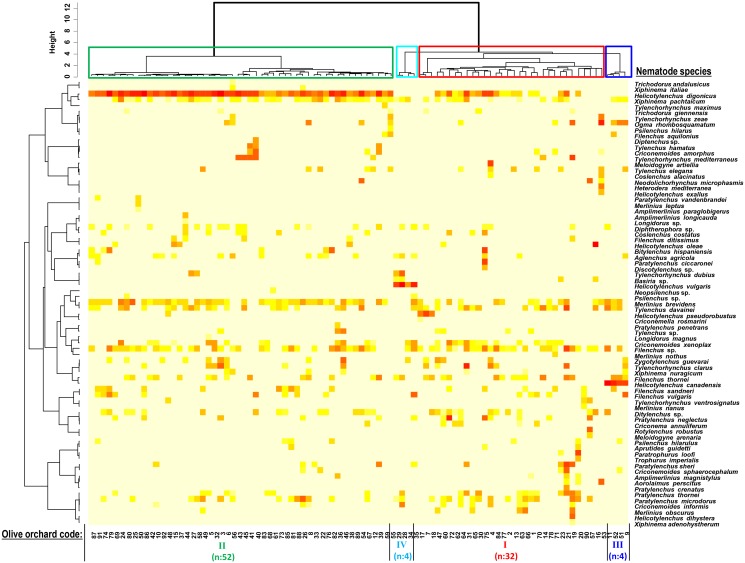
Unsupervised cluster analysis of PPN populations in olive orchards in southern Spain.The Ward linkage method was applied to the Bray–Curtis dissimilarity matrix calculated from frequency of occurrence of the 77 species of PPNs identified among the 92 olive orchard soils sampled. The optimum number of clusters and the degree of membership of an olive orchard to each of the four clusters was estimated on the basis of the maximum average silhouette width according to K-means partitioning (S1 Fig.). The intensity of color (from light yellow to deep red) shown for each nematode species correlates with abundance Log(number of individuals/500 cm3 of soil).